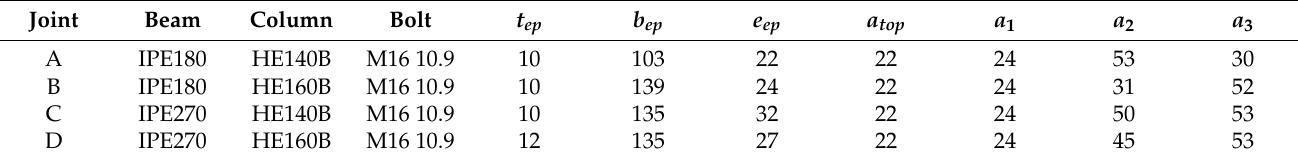
Table 6. Frame A: Final joint details (size in